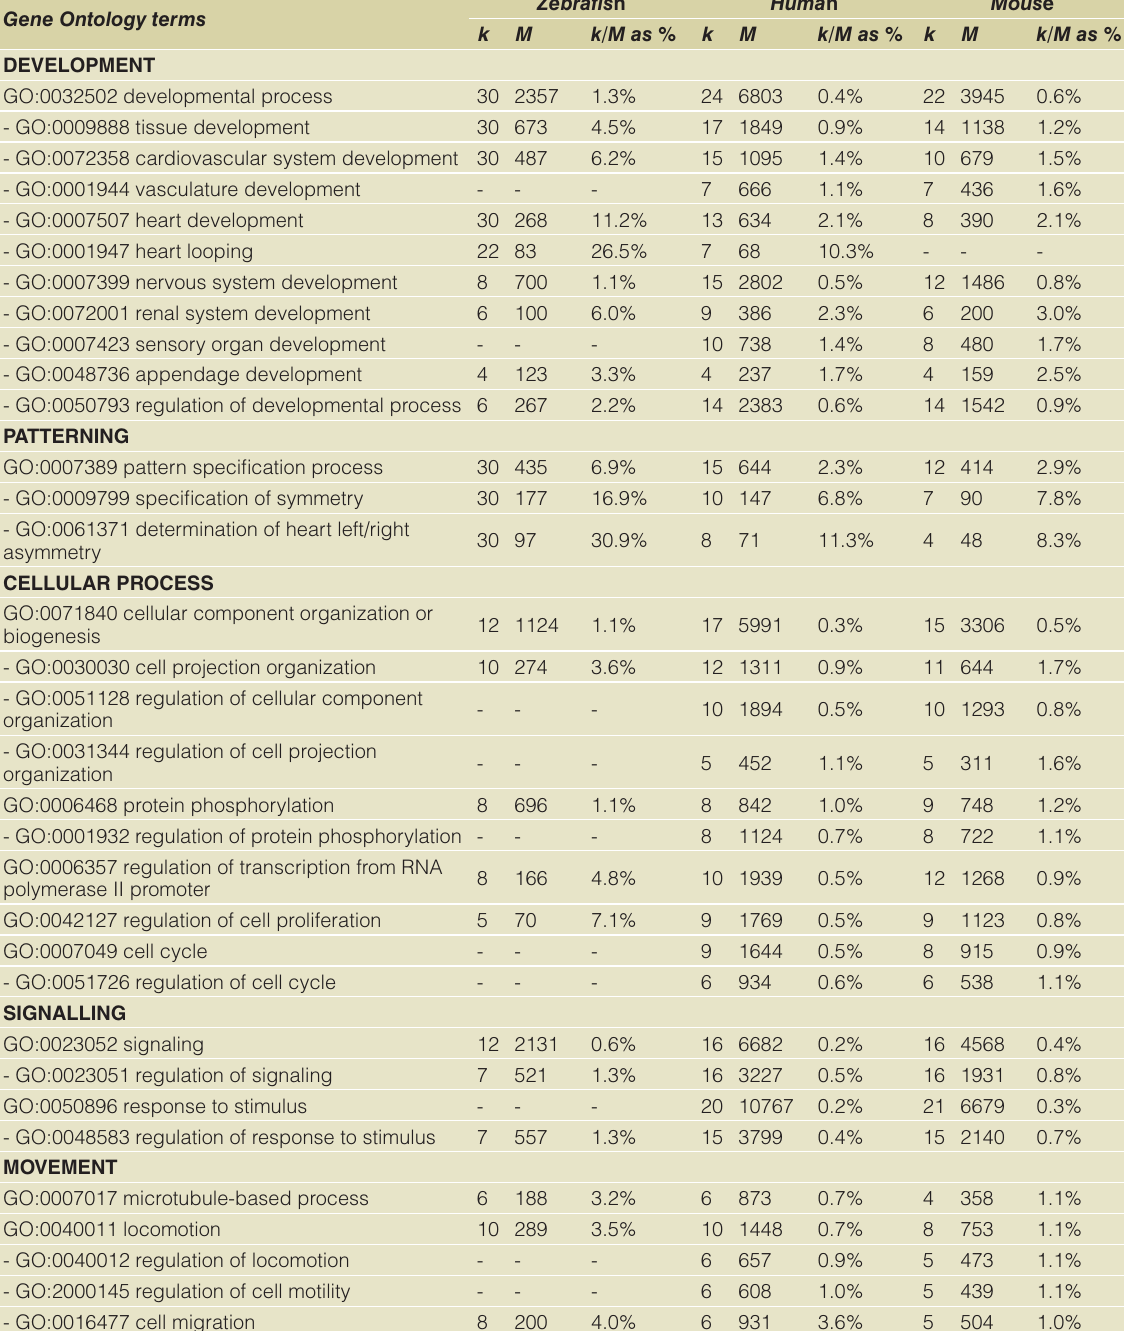
Table 2. Comparison of enriched Gene Ontology terms across orthologous gene lists from zebrafish, human and mouse. The enriched GO terms were grouped into specific ontology areas, with a selection of more specific child term (preceded with a dash) also included. The full list of grouped GO terms can be found in Table S4, which also shows the genes annotated to each term from each of the three species. k: the number of genes in each gene list annotated to the GO term; M: the number of genes in the species proteome annotated to the GO